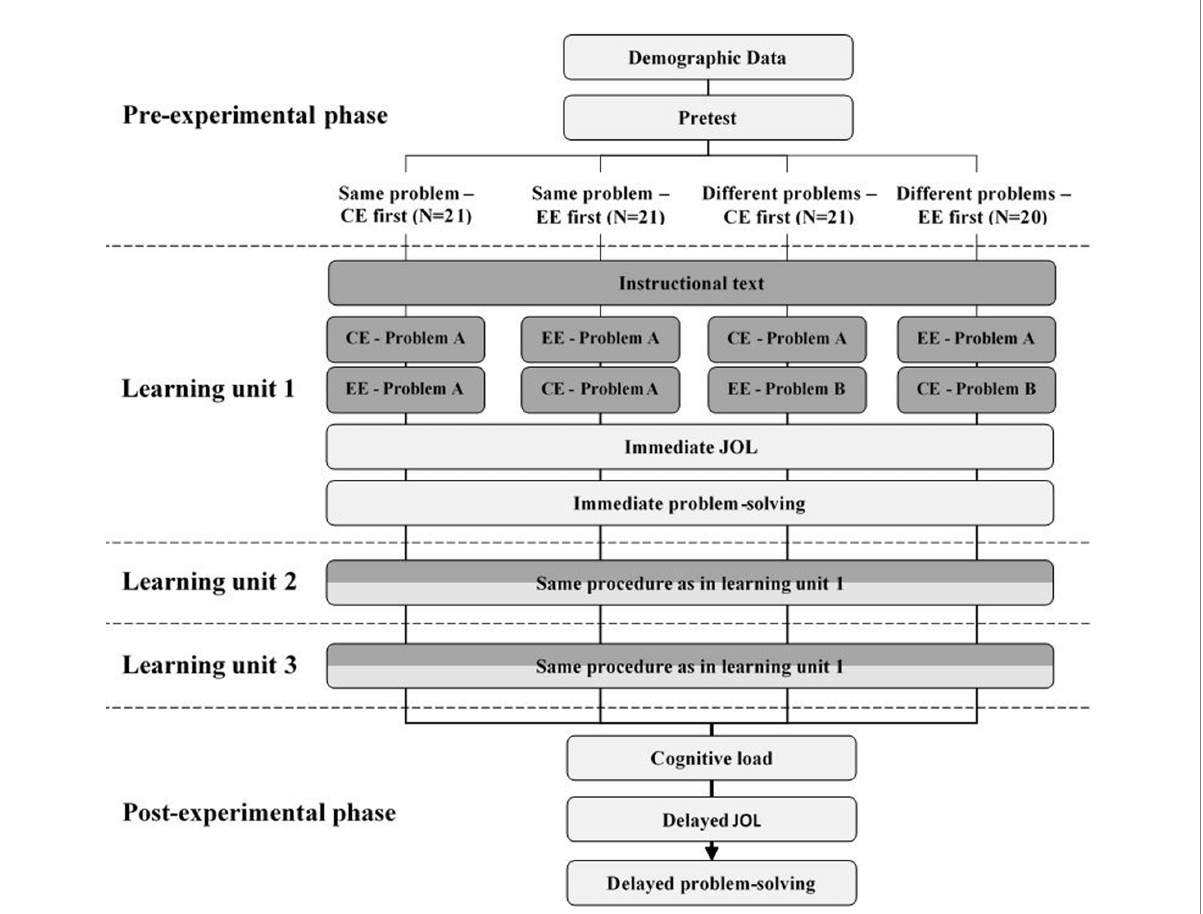
FIGURE 3 Flowchart for the four different experimental conditions. Dark boxes represent learning material, bright boxes represent measures. CE, correct example; EE, erroneous example; JOL, judgment of